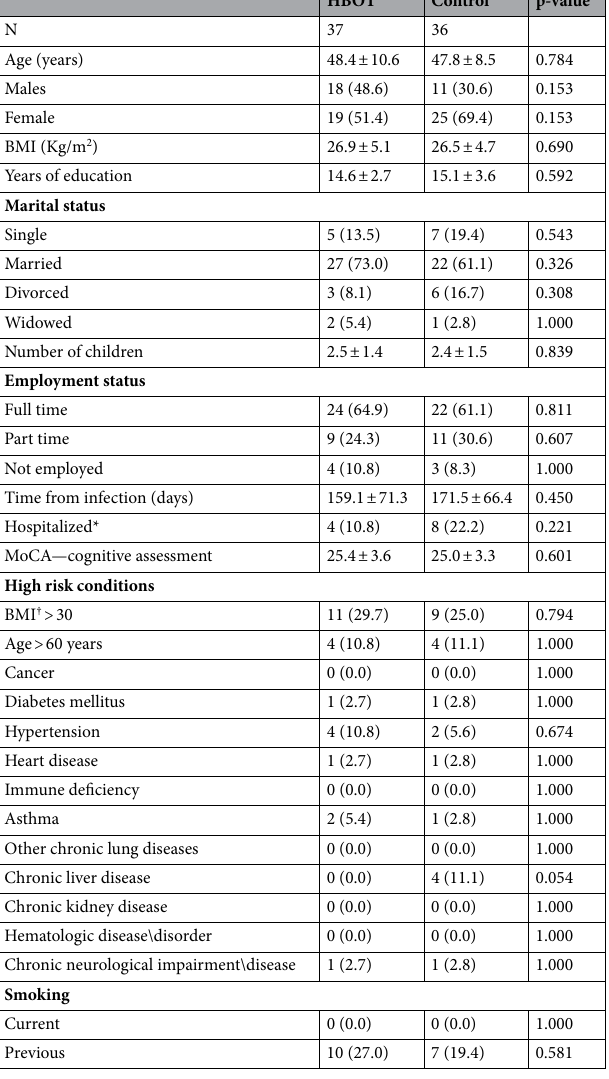
Table 1. Baseline characteristics. Data presented as n (%); continuous data, mean ± SD; † The body-mass index is the weight in kilograms divided by the square of the height in meters. *During COVID-19 infection. MoCA Montreal Cognitive